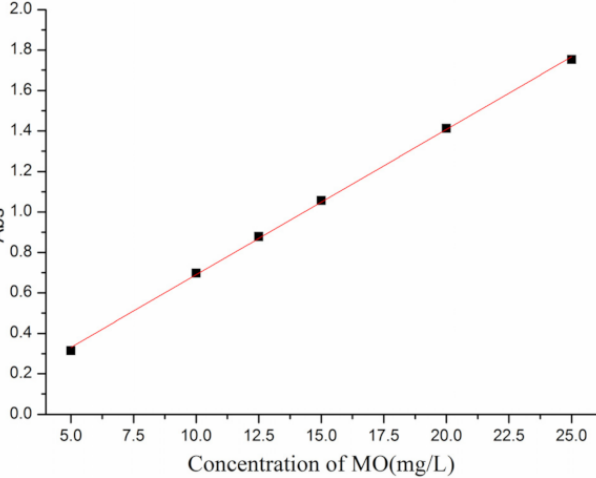
Figure 5. Linear fitting of methyl orange solution with different concentrations and